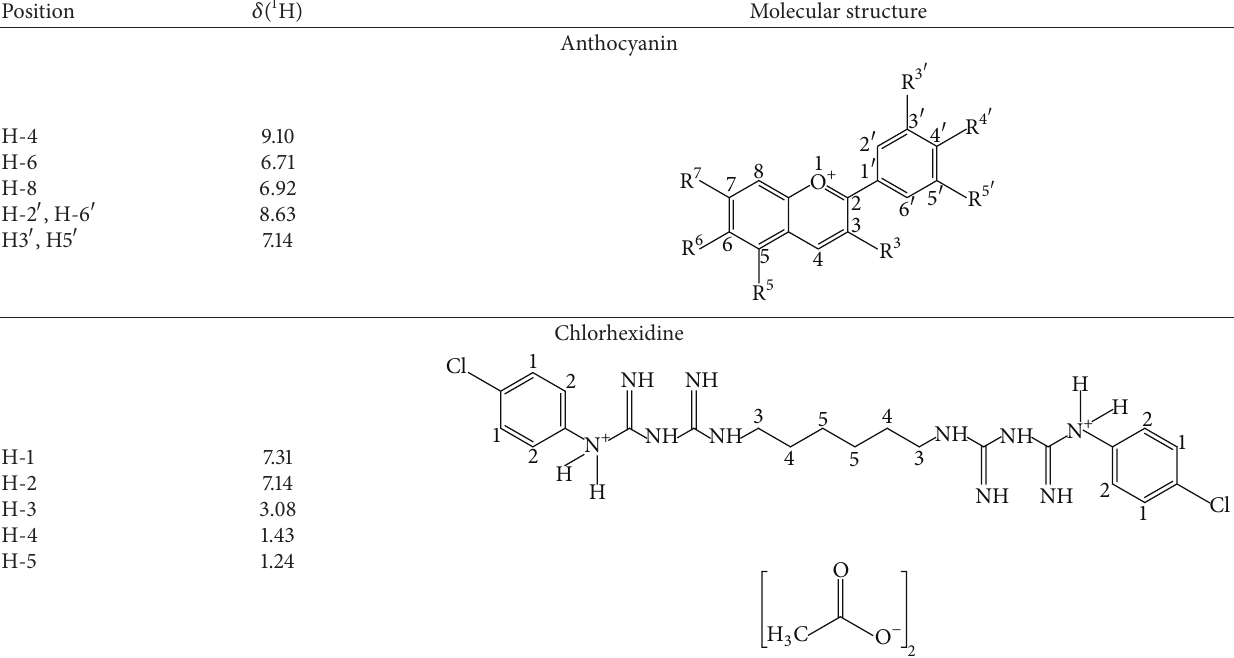
Table 2: 1 H NMR spectroscopic data of the anthocyanin and chlorhexidine diacetate released from a dental copolymer. Position 𝛿 ( 1 H) Molecular